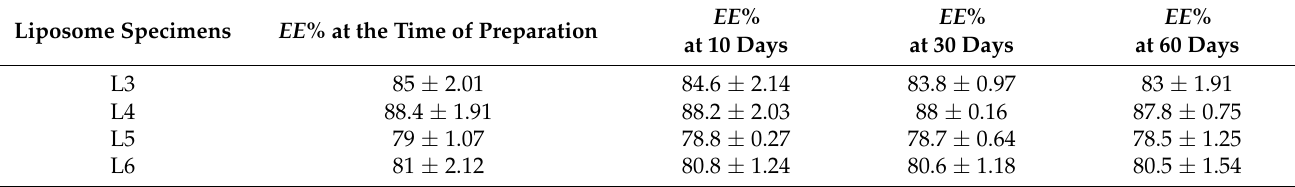
Table 4. The liposome entrapment efficiency at three different storage intervals.